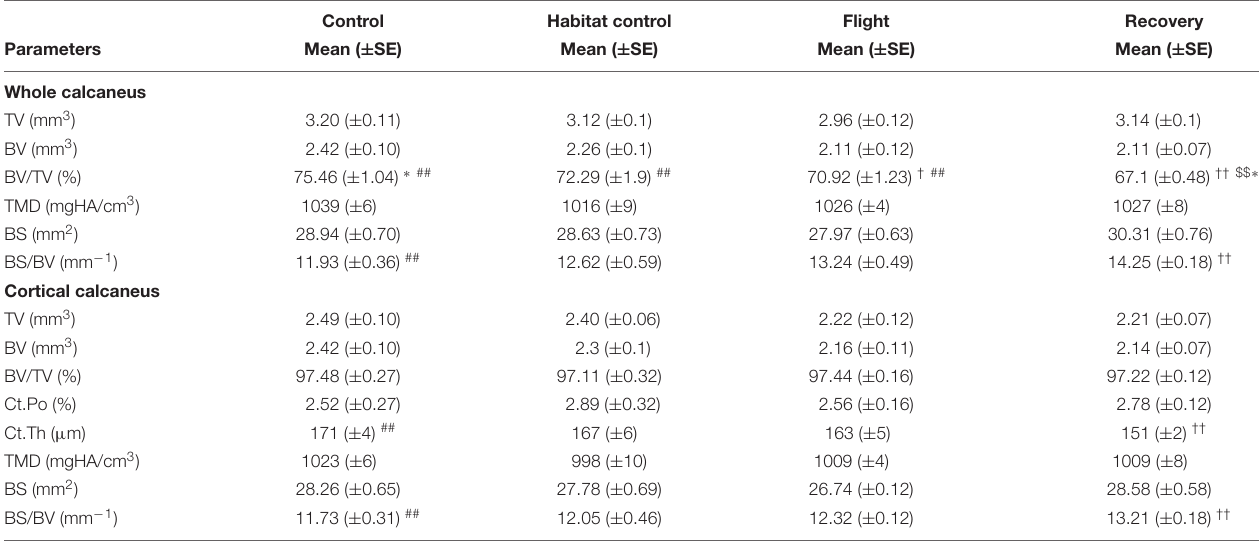
TABLE 3 | Effect of spaceflight, spacecraft housing, and recovery on calcaneus microarchitecture